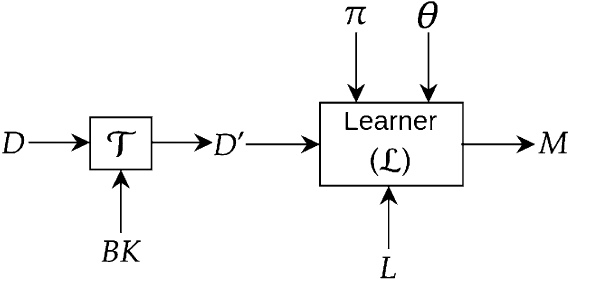
Figure 6. Introducing background knowledge into deep network by transforming data. T is a transformation block that takes input data D , background knowledge ( BK ) and outputs transformed data D construct a deep model using a learner L